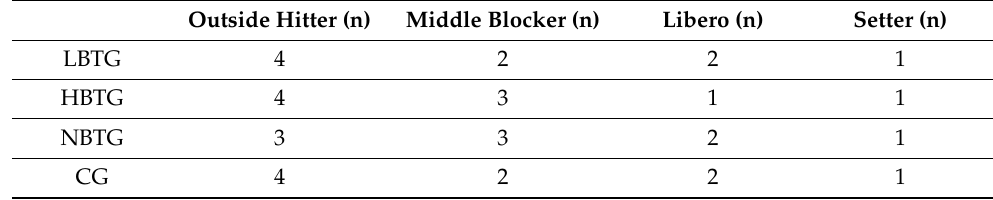
Table 1. The participants in player functions in each group. Outside Hitter (n) Middle Blocker (n) Libero (n) Setter (n) LBTG